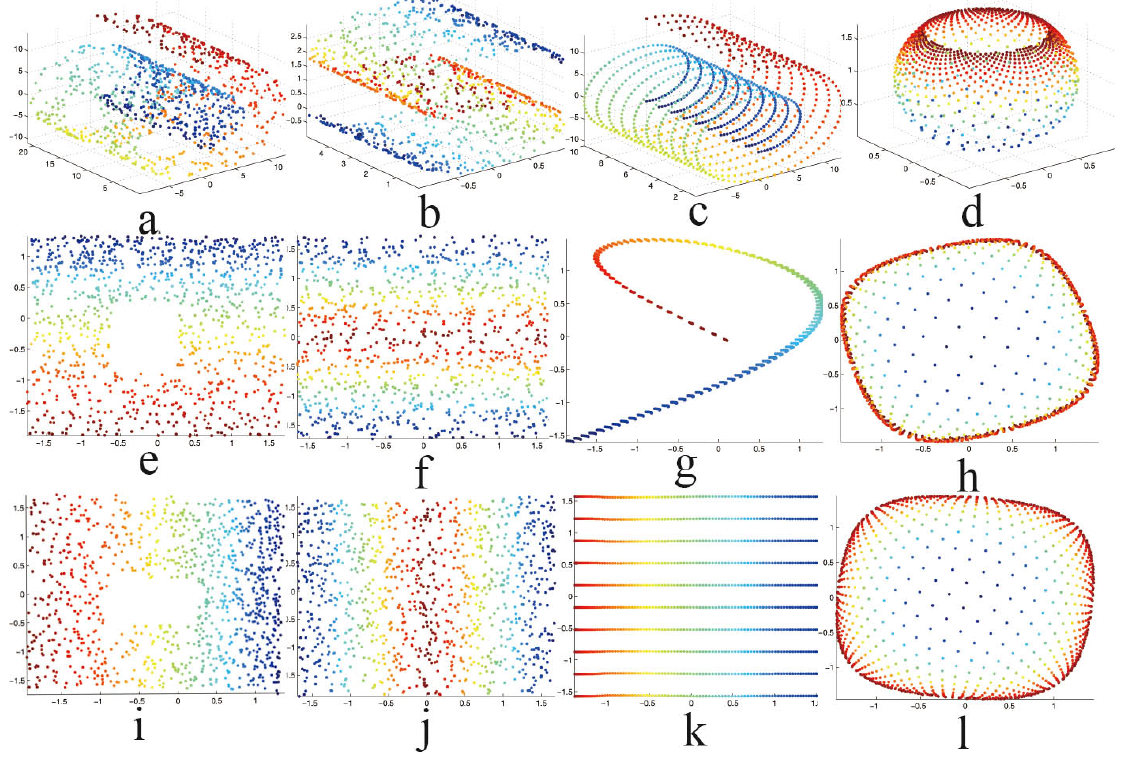
Figure 1. Embeddings of the synthetic 2D manifolds. ( a ) Swiss Roll with a hole; ( b ) S-curve; ( c ) Uniform Swiss Roll; ( d ) Punched Sphere. The first row shows the four manifolds, and the second ( e – h ) and third rows; ( i – l ) are the corresponding embedding results obtained by the original HLLE and our reformulated HLLE respectively. In all experiments, the number of data samples is 1000 and the number of nearest neighbors is fixed to k =